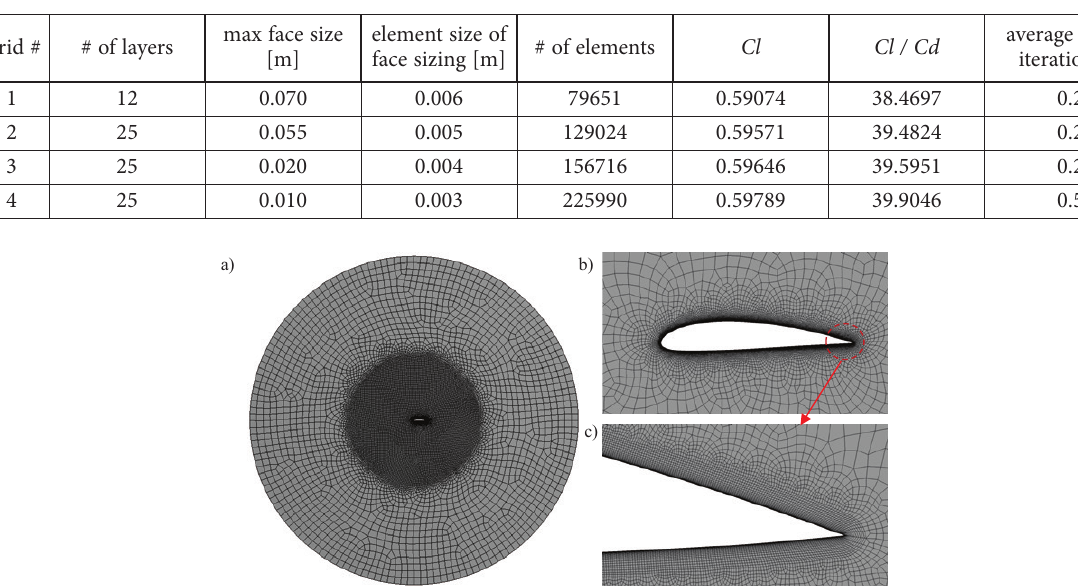
Table 2. Mesh independence study for optimized airfoil at 0° AoA